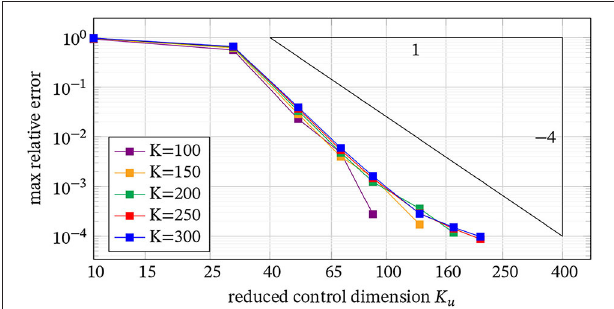
FIGURE 5 | Max error for control dimensions of size K u < K .